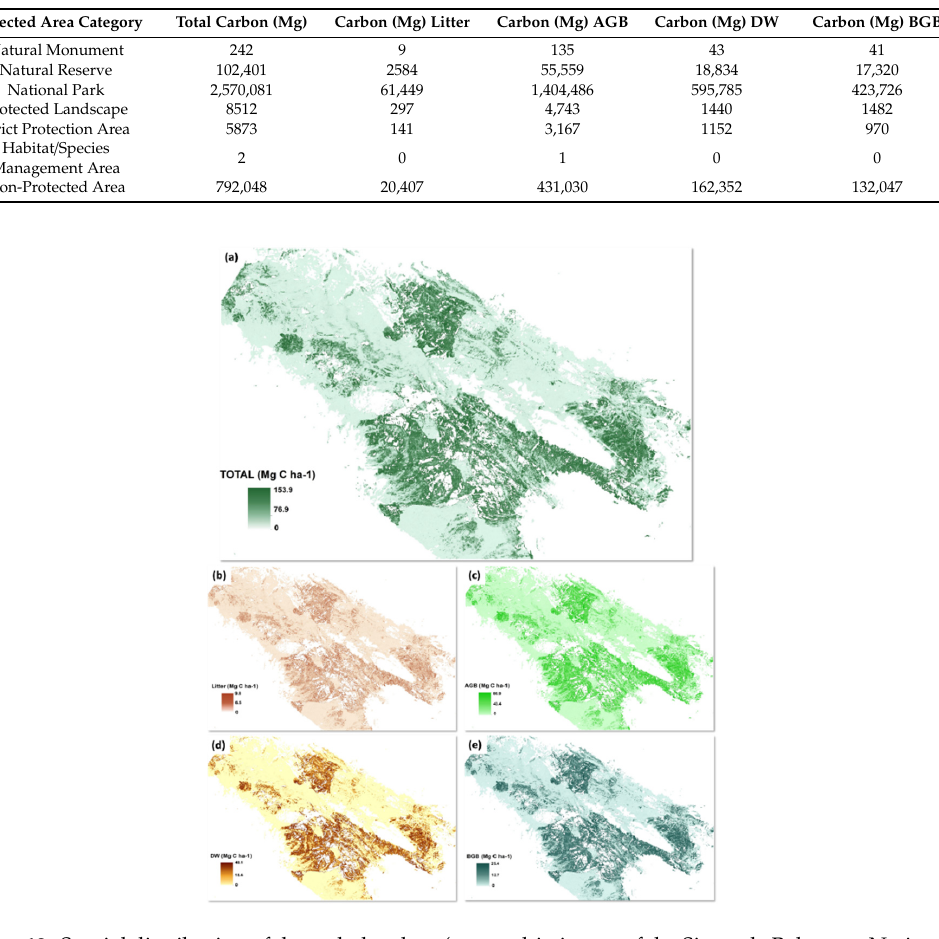
Figure 12. Spatial distribution of degraded carbon (zoomed-in image of the Sierra de Bahoruco National Park protected area with the highest degradation): ( a ) total carbon; ( b ) AGB C; ( c ) BGB C; ( d ) DW C; ( e ) litter C in the pine forests of the Dominican Republic.